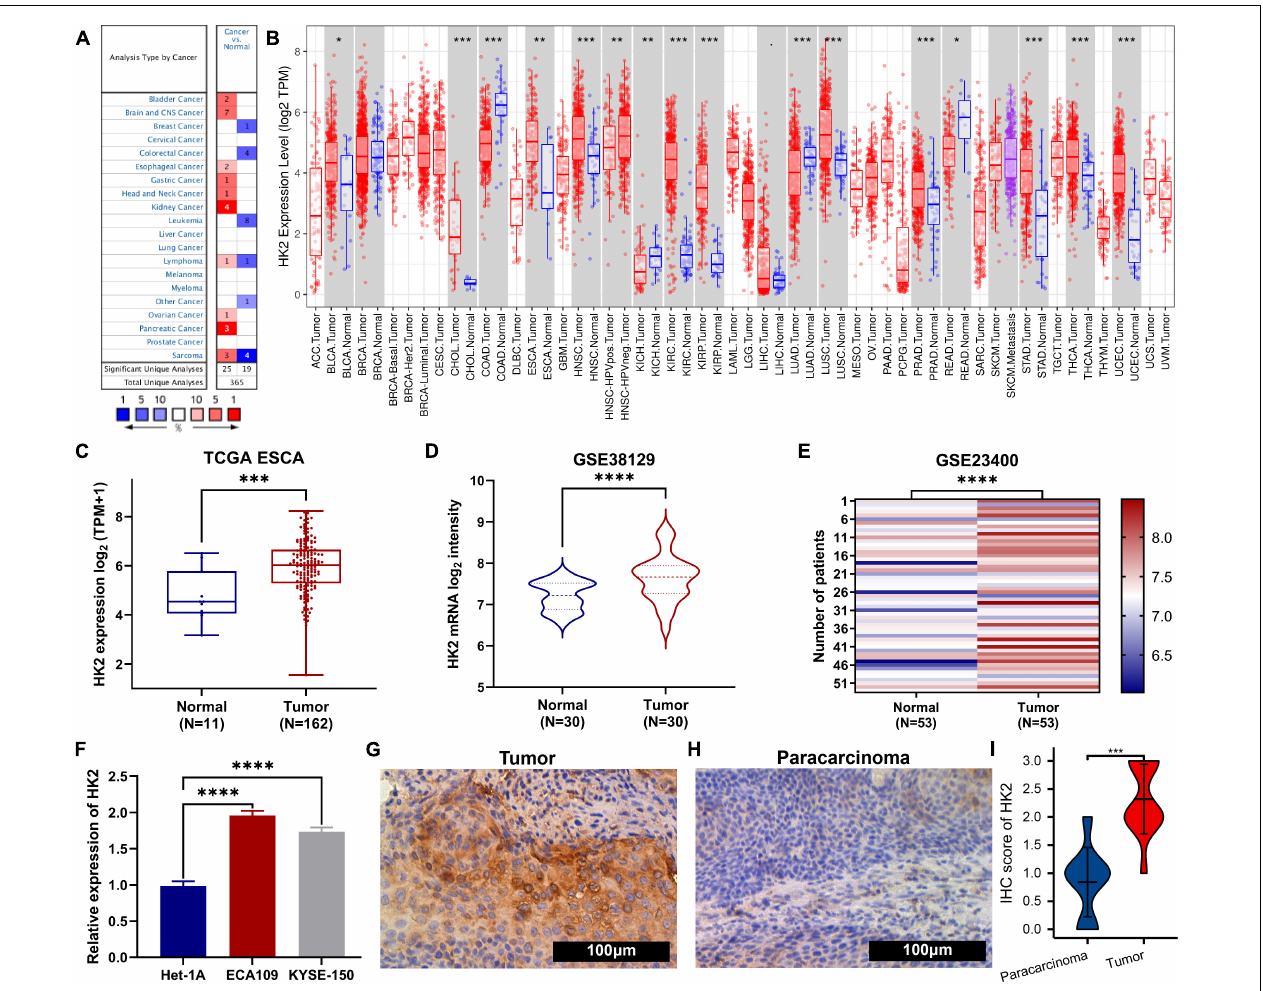
FIGURE 1 | The expression of HK2 in esophageal carcinoma (ESCA) and pan-carcinoma. (A) Oncomine analysis showed the expression level of HK2 mRNA in different tumor types. (B) The TIMER ESCA cohort shows that HK2 mRNA expression levels in different tumor types. (C) Differential expression of HK2 in ESCA and normal tissues was analyzed by TCGA ESCA cohort (D) Difference expression of HK2 in ESCA and normal tissues was analyzed by GSE38129 cohort. (E) Difference expression of HK2 between ESCA and matched normal tissues in GSE23400 cohort. (F) Difference expression of HK2 in different ESCA cell lines and human normal epithelial cell lines. Immunohistochemical staining showed the expression of HK2 in ESCA samples (G) and paracarcinoma samples (H) . (I) The mean HK2 IHC score in ESCA tissue (2.32 ± 0.621) was significantly higher than that of matched peritumoral tissue (0.84 ± 0.618). ∗ P < 0.05; ∗∗ P < 0.01; ∗∗∗ P < 0.001; ∗∗∗∗ P <